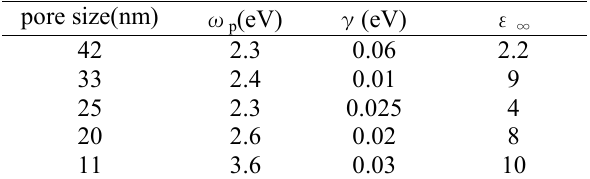
Table 1: Plasmon parameters.